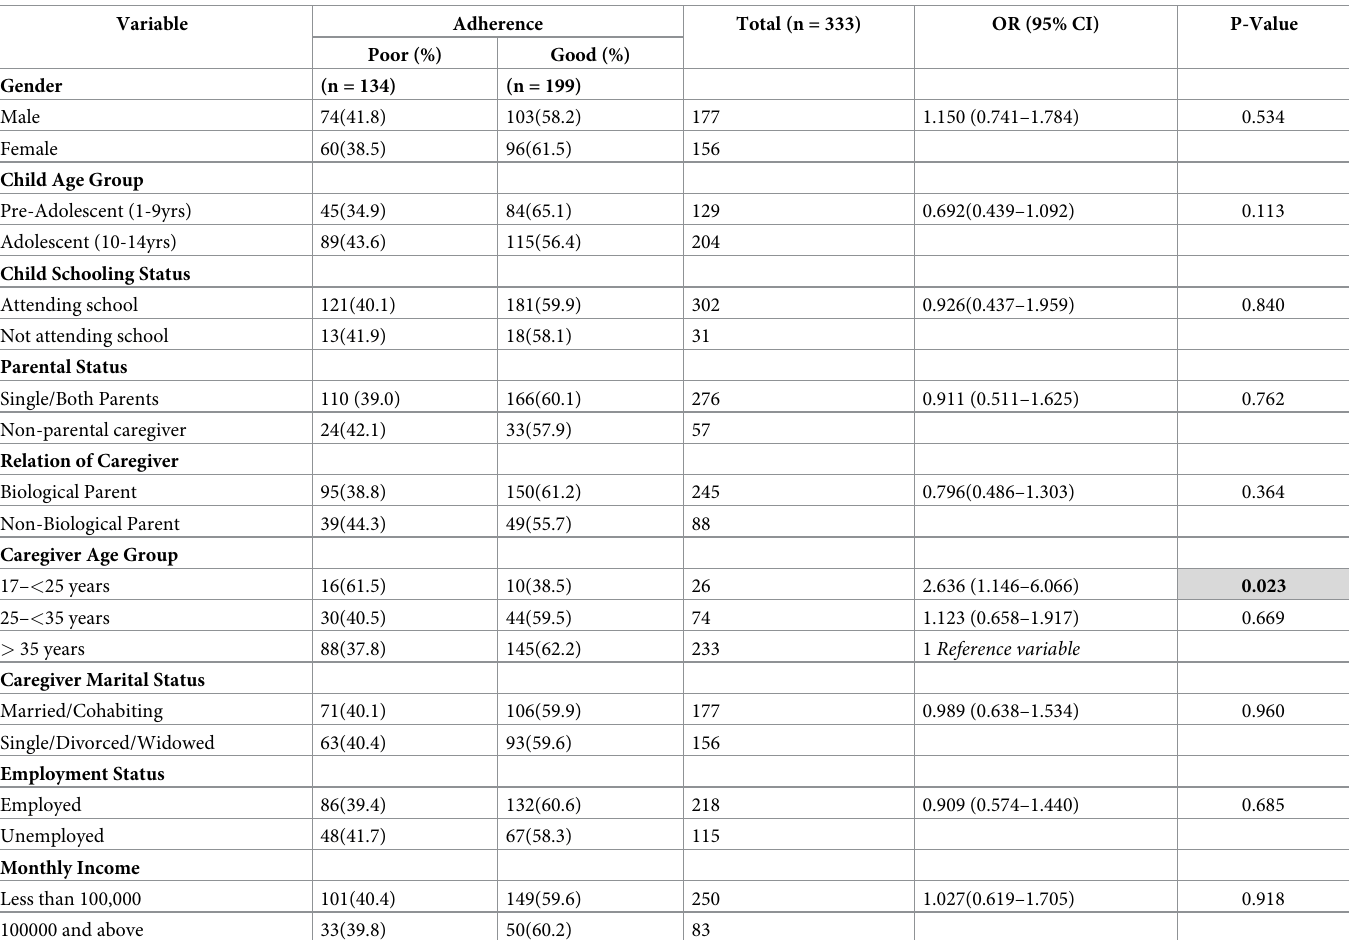
Table 2. Socio-demographic characteristics associated with ART